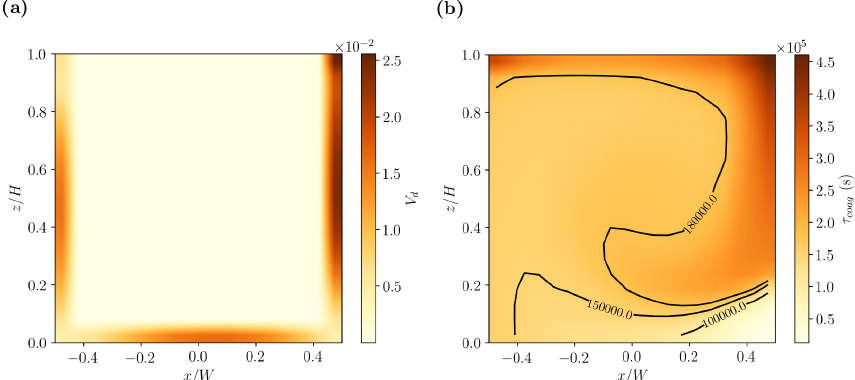
Figure 13. Comparison of characteristic timescales for NG-D. (a) v d (or (cid:49)/τ d ); (b) τ coag .